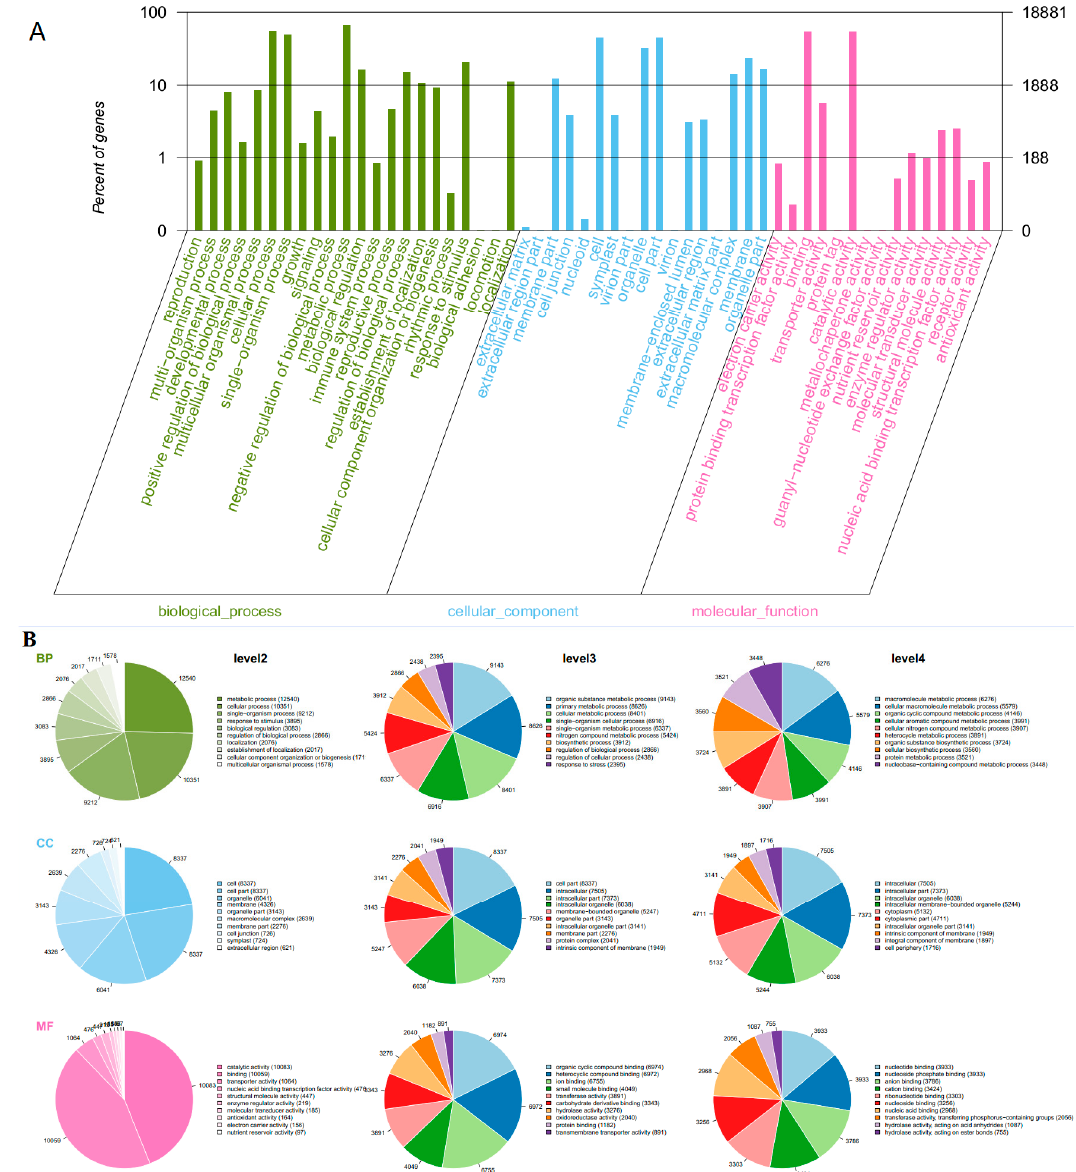
Figure 3. Gene Ontology (GO) functional annotation of genes detected in grape berries. ( A ) the right y -axis represents the number of genes in a sub-category. The left y -axis indicates the percentage of a specific sub-category of genes in each main category; ( B ) classification of GO terms. BP, biological process; CC, cellular component; MF, molecular function.